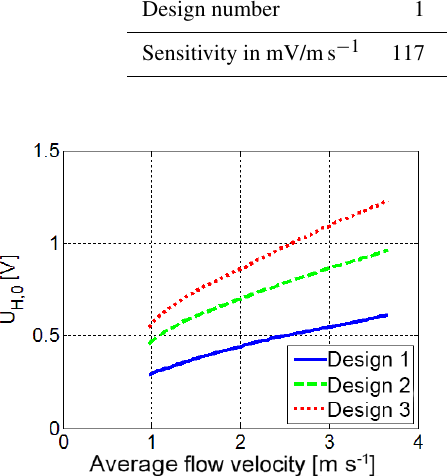
Figure 11. Comparison of the output characteristic of three dif- ferent transducer designs (calorimetric approach) where the wing width was varied. The wing widths for designs 4, 7, and 9 amount to 0.2, 4.2, and 8.86mm,